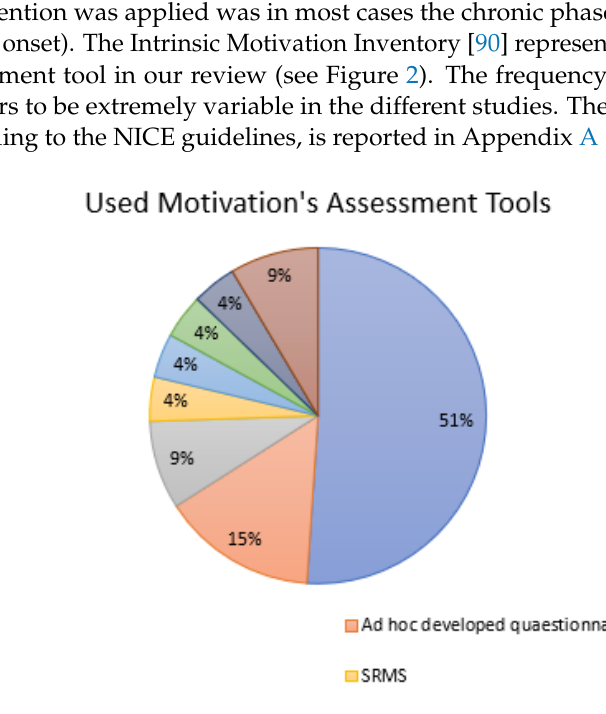
Figure 2. Used motivation assessment tools. Abbreviations: IMI: Intrinsic Motivation